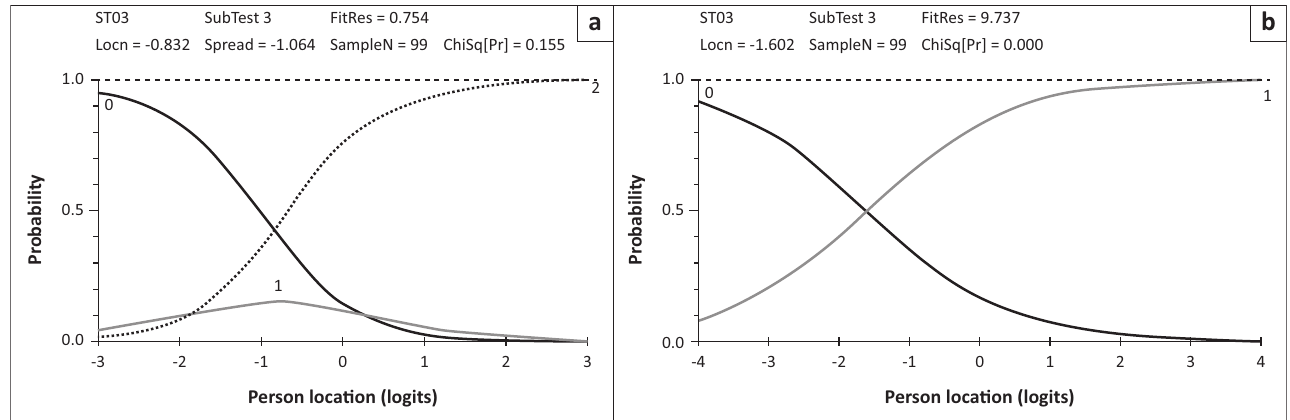
FIGURE 7: (a) Subtest 3 (question 6), (b) Subtest 3 (question 6) – re-scored.